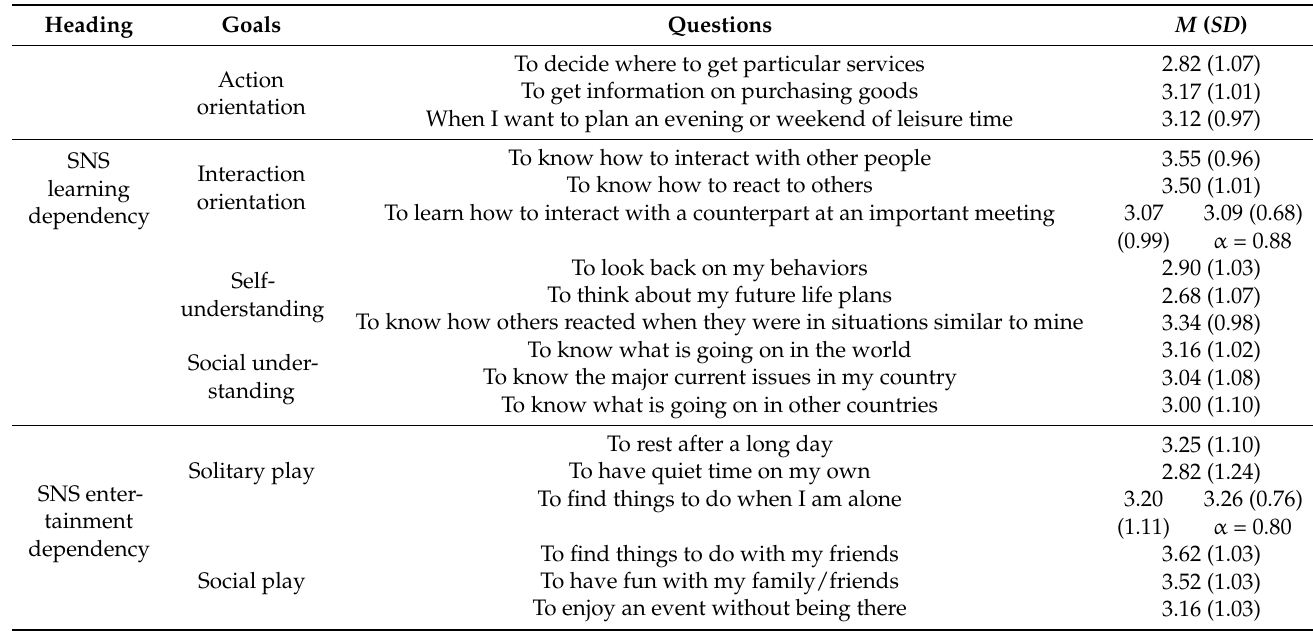
Table 1. Questions used for measuring SNS